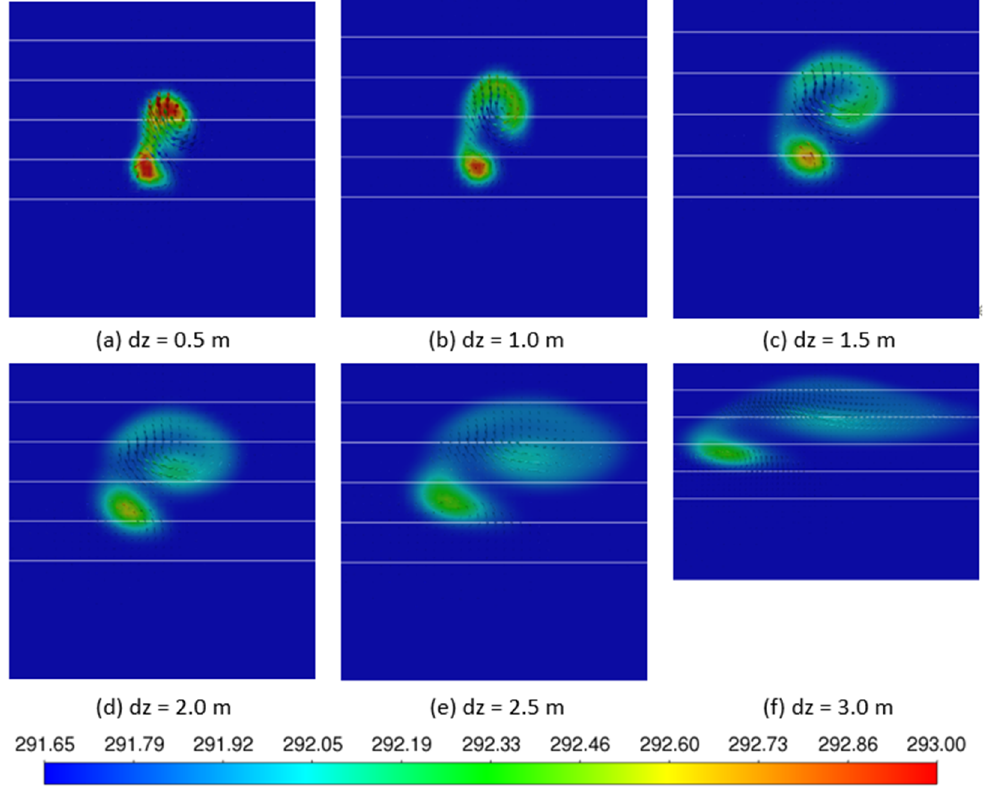
Figure 14. Temperature cloud and velocity vector at different sections behind the underwater vehicle.